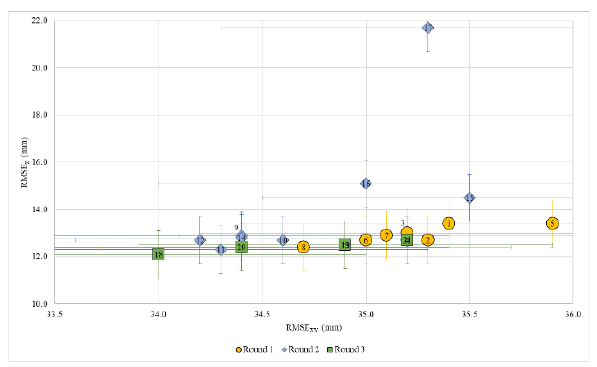
Figure 11 . Results from third round of testing.